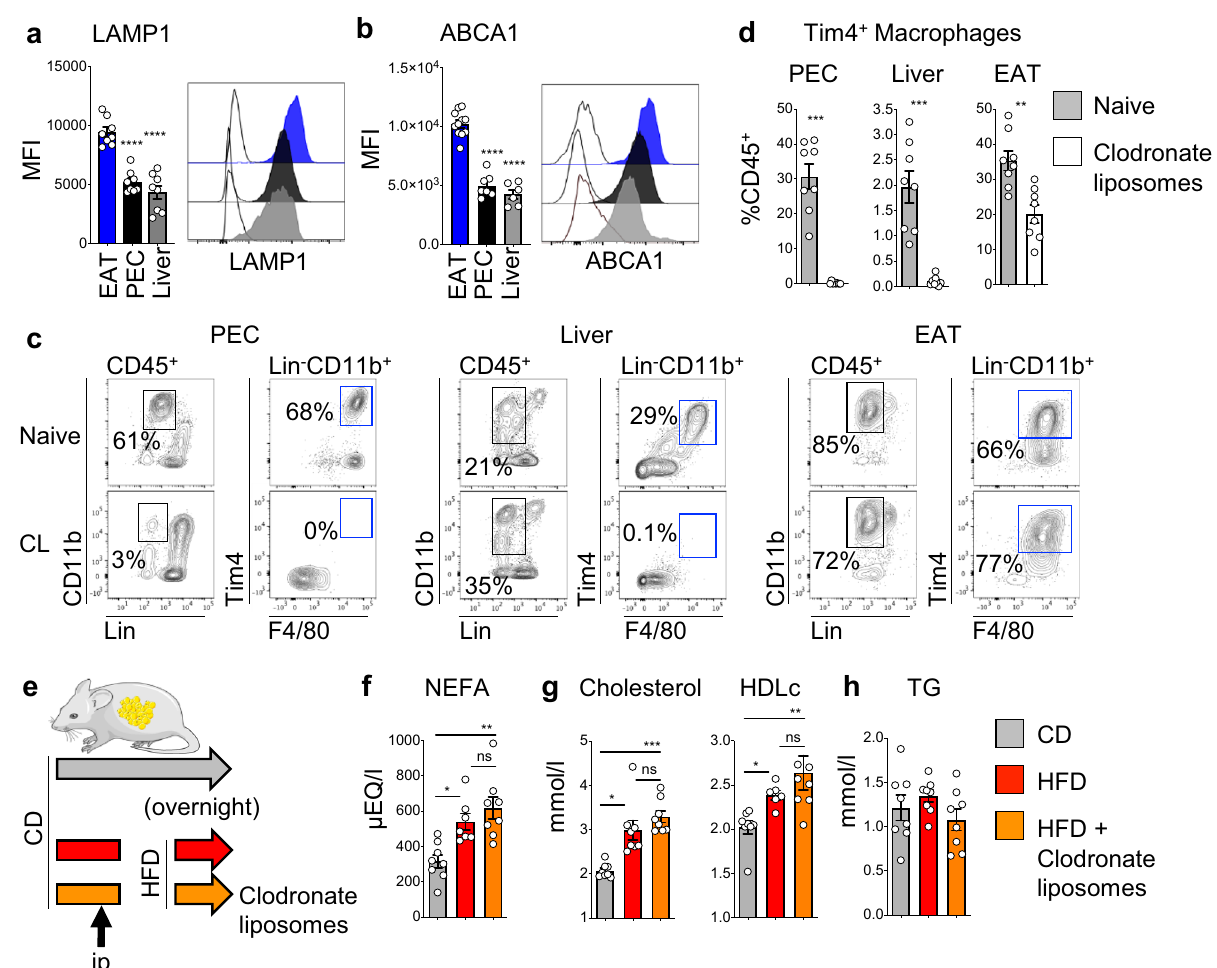
Fig. 7 Depletion of liver and peritoneal macrophages does not alter post-prandial cholesterol metabolism. a , b Quanti fi cation of lysotracker ( a ) and ABCA1 ( b ) mean fl uorescence intensity (MFI) and representative histogram of the fl uorescence intensity for Tim4 + macrophages in the epididymal AT (EAT), peritoneal cavity exudate cells (PEC), and liver (gating shown in c ). c , d Flow cytometric analysis showing gating strategy ( c ) used to quantify the percentage of Tim4 + macrophages ( d ) present in the PEC, liver, and EAT of naive mice (gray bar) and mice that received clodronate liposomes 24 h prior to analysis (white bar). Data are pooled from n = 8 mice per group from 2 independent experiments. e Mice were kept on chow diet or fed with a HFD overnight. One group of mice fed a HFD were injected i.p. with clodronate liposomes 24 h prior to the overnight HFD. f – h Circulating levels of NEFA ( f ), total cholesterol and HDLc ( g ), and TG ( h ) in mice kept on CD (gray bar), mice fed overnight with HFD (red bar), and mice fed overnight with HFD and injected with clodronate liposomes (orange). Data are pooled from n = 7 or 8 mice per group from 2 independent experiments. Error bars show SEM. Kruskal – Wallis test with Dunn ’ s multiple comparisons test or ANOVA with Sidak ’ s multiple comparisons test were applied after assessing normality using D ’ Agostino and Pearson Normality test. Signi fi cant differences are indicated by * P < 0.05, ** P < 0.01, *** P < 0.001, **** P < 0.0001, ns = non-signi fi